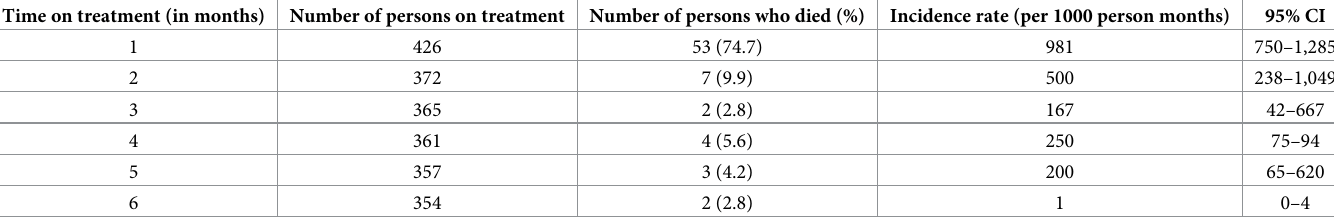
Table 4. Time to death for persons with TB treated in Itezhi-Tezhi District (2015–2018), n = 426. Time on treatment (in months) Number of persons on treatment Number of persons who died (%) Incidence rate (per 1000 person